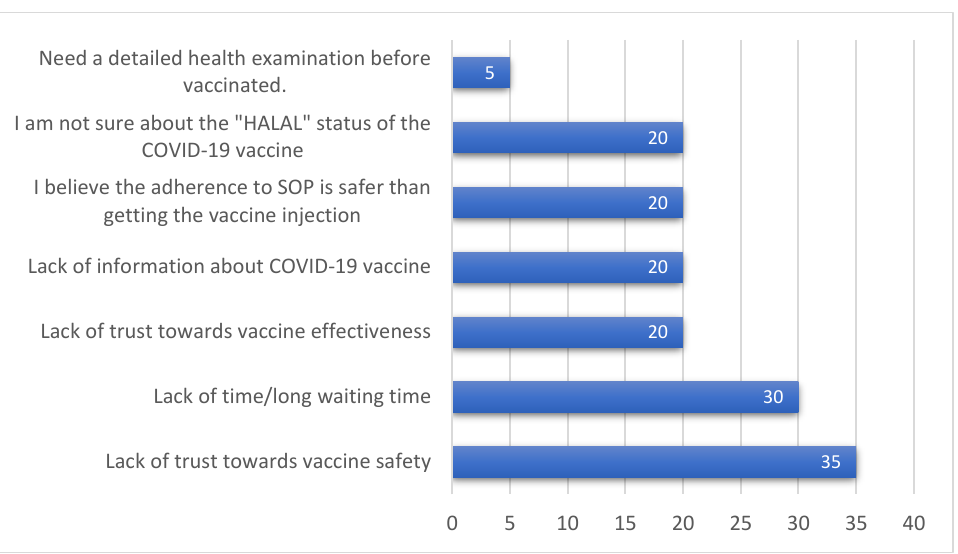
Figure 1. Percentages of common reasons for hesitancy to register or receive the COVID-19 vaccina- tion.